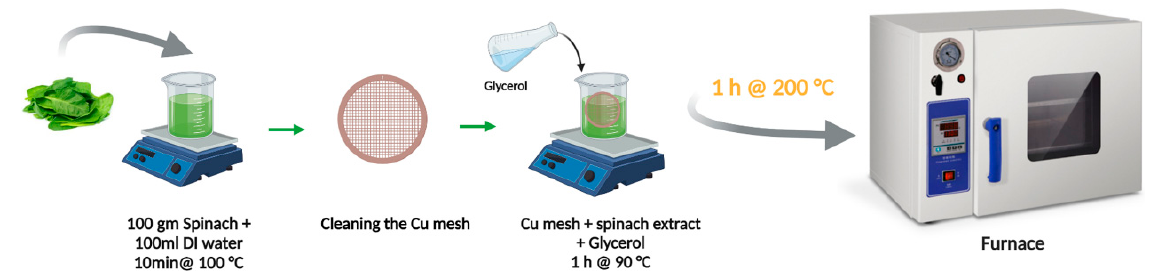
Figure 1. An illustration of the green synthesis steps, materials and equipment for preparing the catalyst Cu 2 O-Cu(OH) 2 @Cu mesh (Created with BioRender.com).